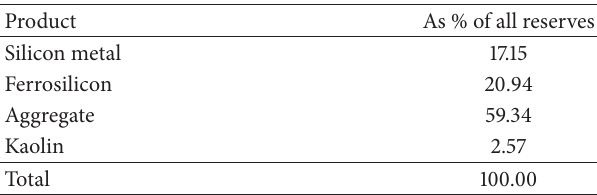
Table 2: Commercial grade